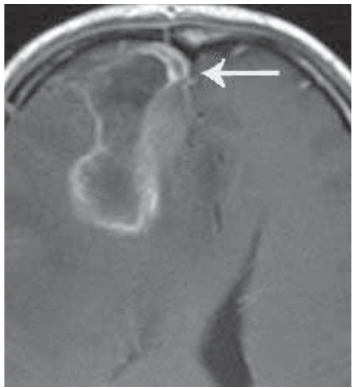
FIGURE 7. The control MR axial contrast- enhanced T1-weighted image shows a heterogeneously enhanced tumour, with dural tail sign medial of the tumour. Histo- pathology exam revealed the glioblastoma